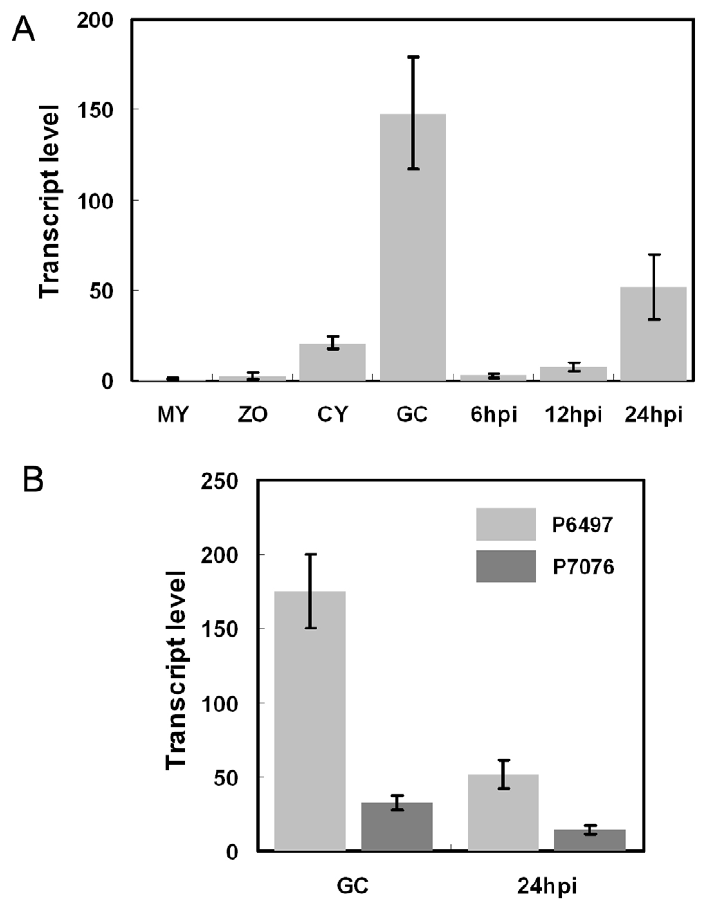
Figure 2. Avr3b is induced during infection and shows transcriptional polymorphisms. ( A ) Avr3b transcript levels in different developmental and infection stages measured by real-time RT-PCR. Total RNA was extracted from mycelia (MY), zoospores (ZO), cysts (CY), germinating cysts (GC), and infected soybean leaves at 6 hours post-infection (hpi), 12 hpi, and 24 hpi. All inoculations for RNA isolation were performed on susceptible soybean cultivar Williams. Real-time RT-PCR analysis employed primers specific for Avr3b and the actin gene. Transcrip level represent the P. sojae Avr3b mRNA levels compared with actin mRNA levels. Bars represent standard errors from 2 independent replicates each. ( B ) Avr3b transcriptional polymorphism between virulent (P7076) and avirulent (P6497) strains. Real-time RT-PCR analysis was conducted to compare Avr3b transcript levels at two infection-related stages, germinating cysts (GC) and infected leaves (24 hpi). Primers used in this assay amplified identical regions from Avr3b P6497 and Avr3b P7076 . Bars represent standard errors from 2 independent replicates